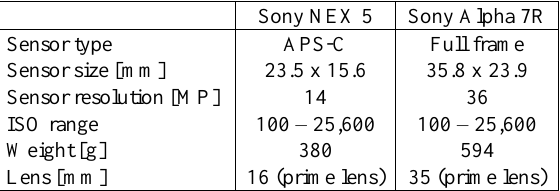
Table 4. Technical specifications of the